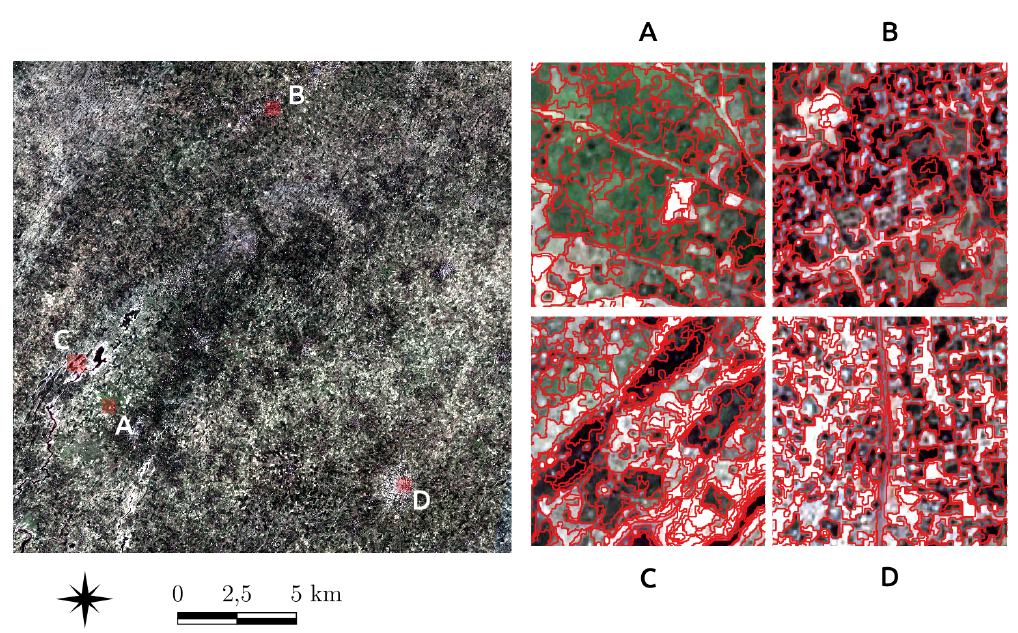
Figure 4. Some details about the segmentation performed on the Reunion island.